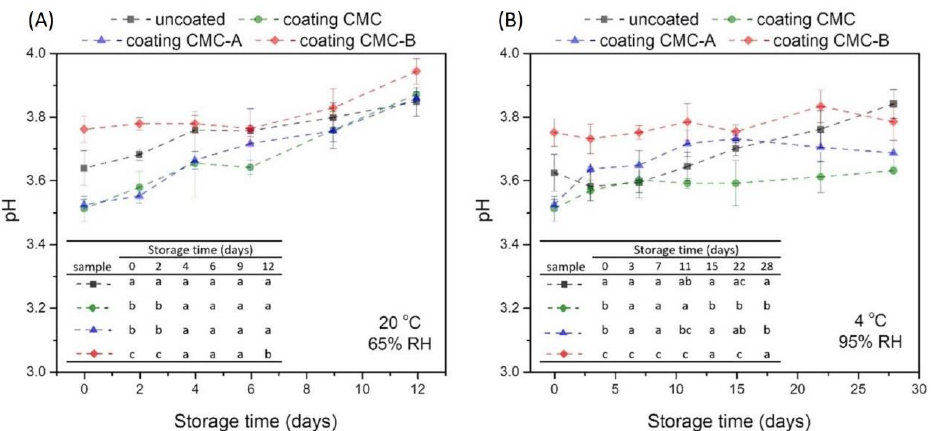
Figure 3. pH of the fresh goldenberries (coated and uncoated) during storing at 20 °C and 65% RH ( A ) and 4 °C and 95% RH ( B ). Results are expressed as mean ± standard deviation ( n = 4). In the inserted table, different letters on the same analysis day correspond to statistically different values for a 95% confidence level.